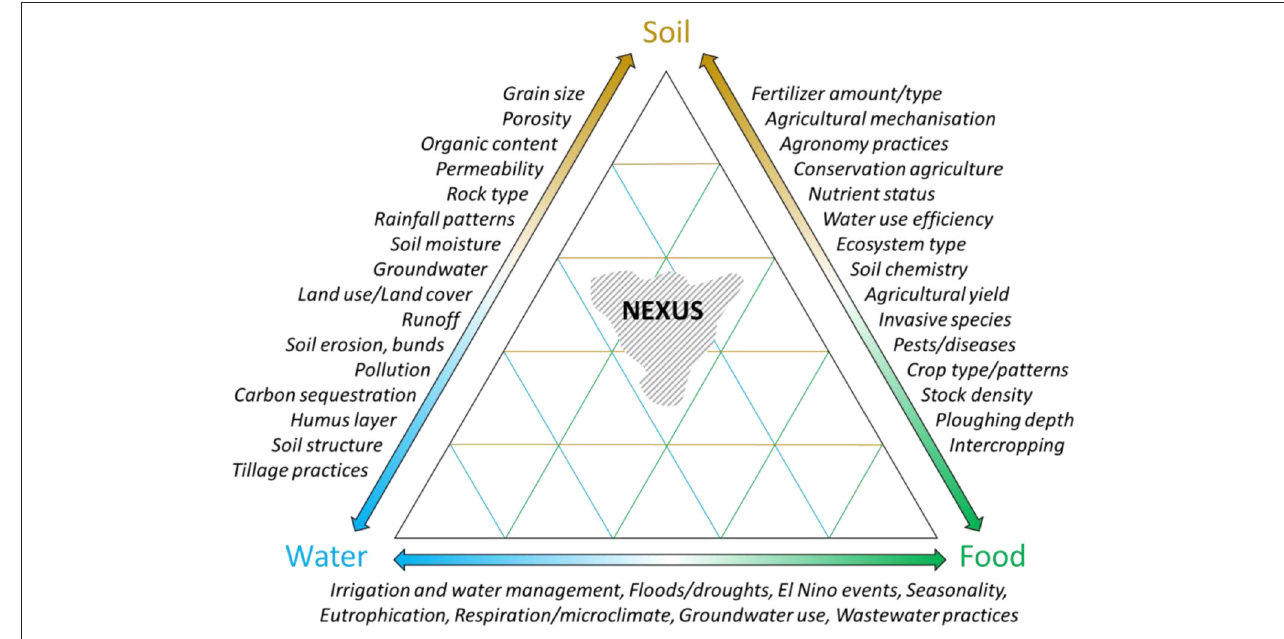
FIGURE 1 | Illustration of the interconnections between soil, food, and water systems and the particular elements that link these systems together (listed around the outside of the triangle). The soil–food–water nexus represents some poorly-defined region in the middle of this triangle